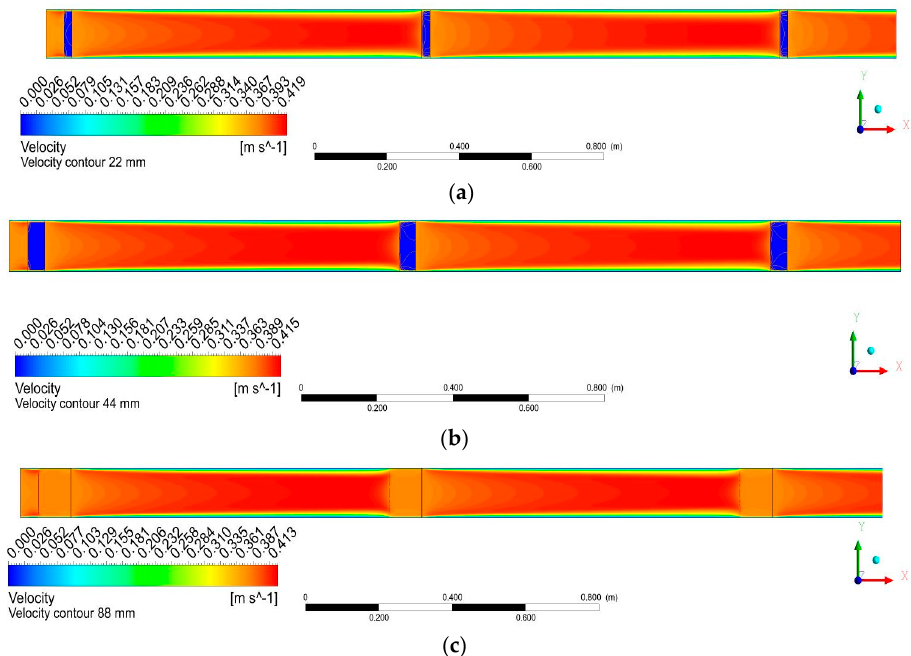
Figure 8. Contour of velocity distribution for 30 PPI 0.92 porosity copper metal foam at 0.3779 m/s velocity for ( a ) 22 mm, ( b ) 44 mm and ( c ) 88 mm thick metal foam.